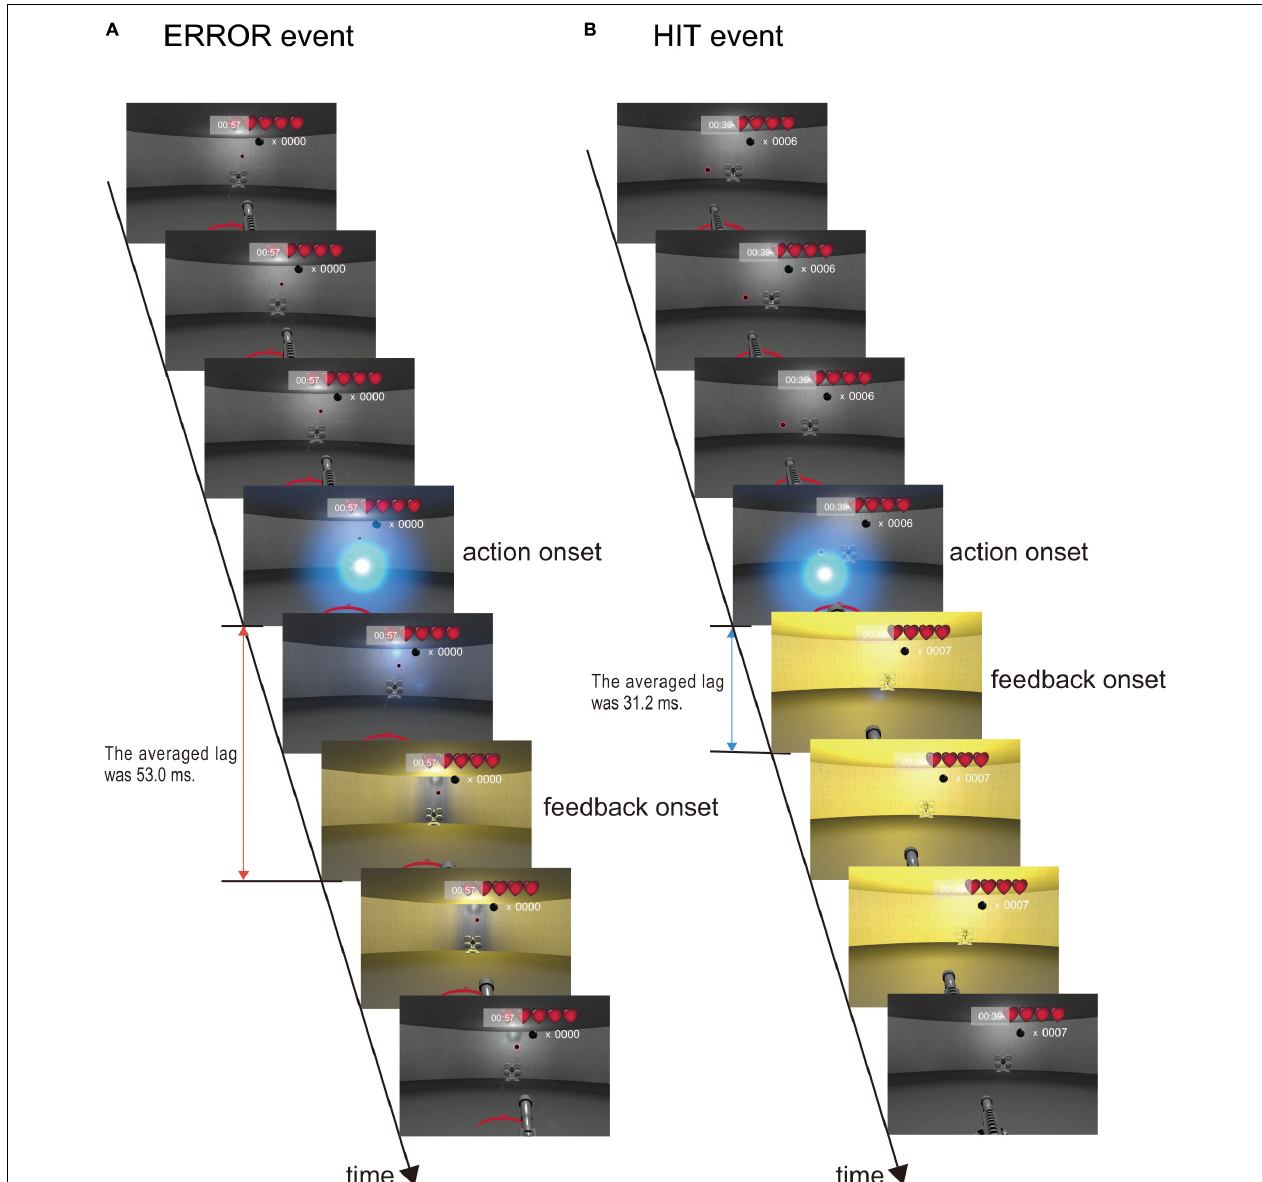
FIGURE 3 | Criteria for two event onsets. We focused on the two game events. The blue sphere was the bullet fired by the participants. (A) ERROR event. The bullet fired by the participants flew in a direction different from the position of the cannonball. The ball hit the wall and the cannonball did not disappear. The scene appears in approximately 3 s, as shown in Supplementary Video 1 . (B) HIT event. The bullet fired by the participants flew into position on a cannonball. The ball hit the cannonball, and the cannonball disappeared. The scene appears in approximately 21 s in Supplementary Video 1